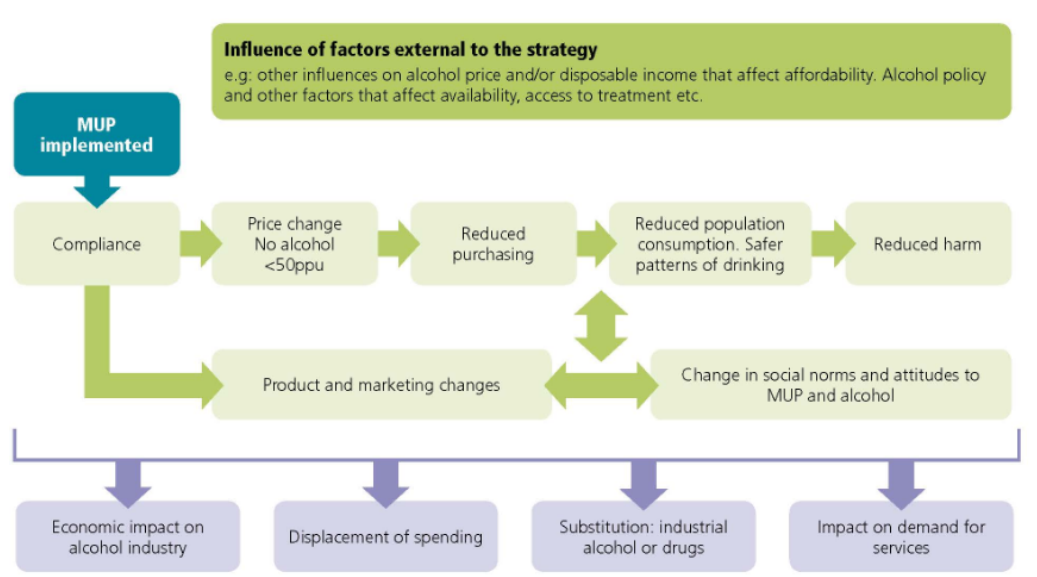
Figure 1. Theory of Change for minimum unit pricing for alcohol.